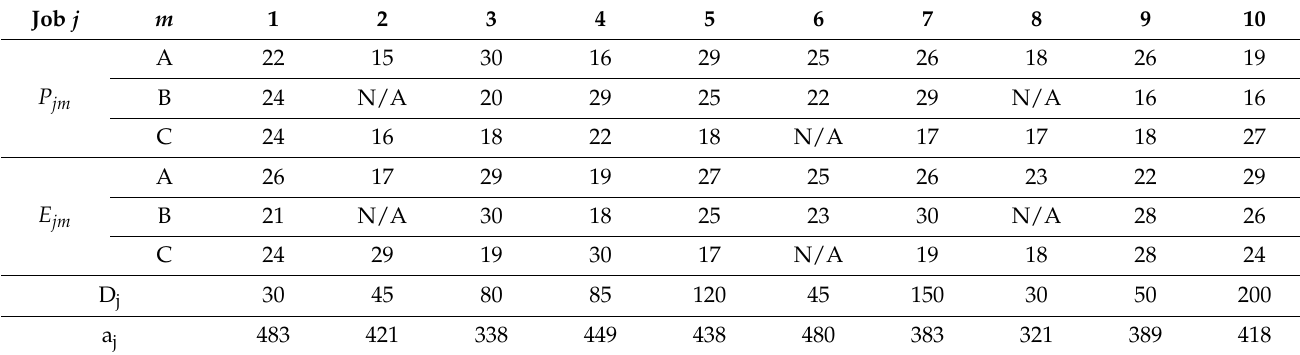
Table 2. Values of P jm and E jm for 10 jobs and 3 machines.